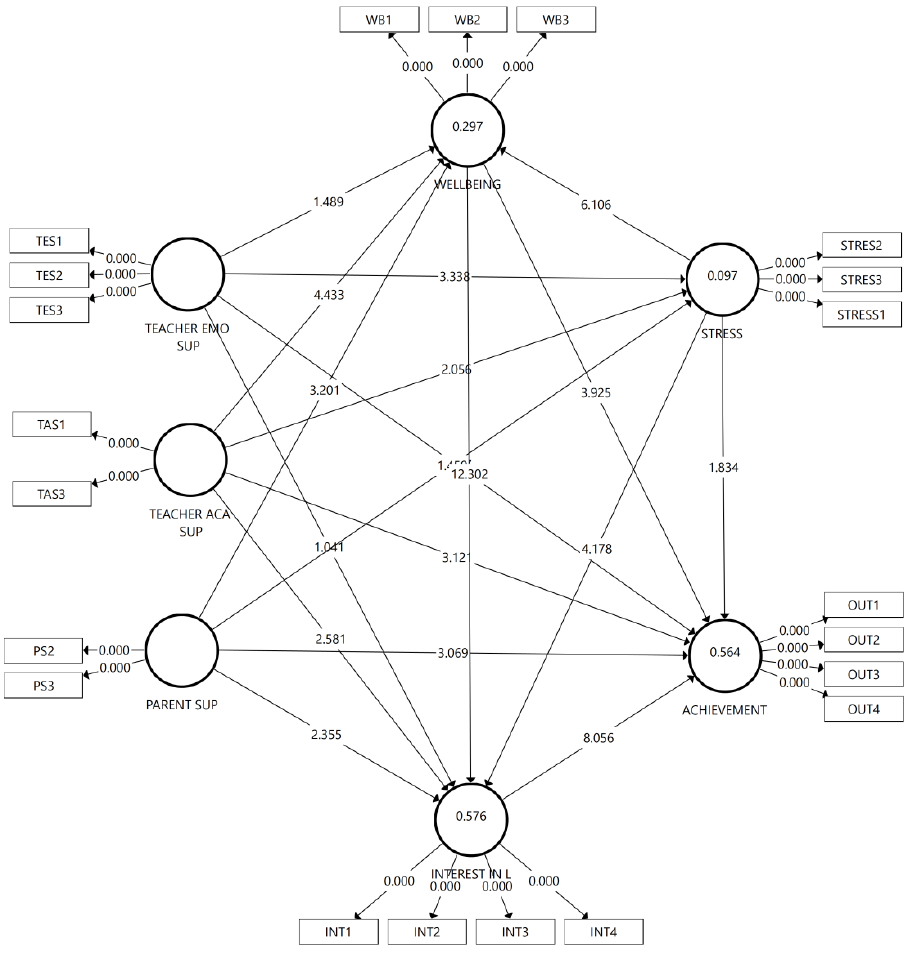
Figure 2. Final model with R square, p , and t values.